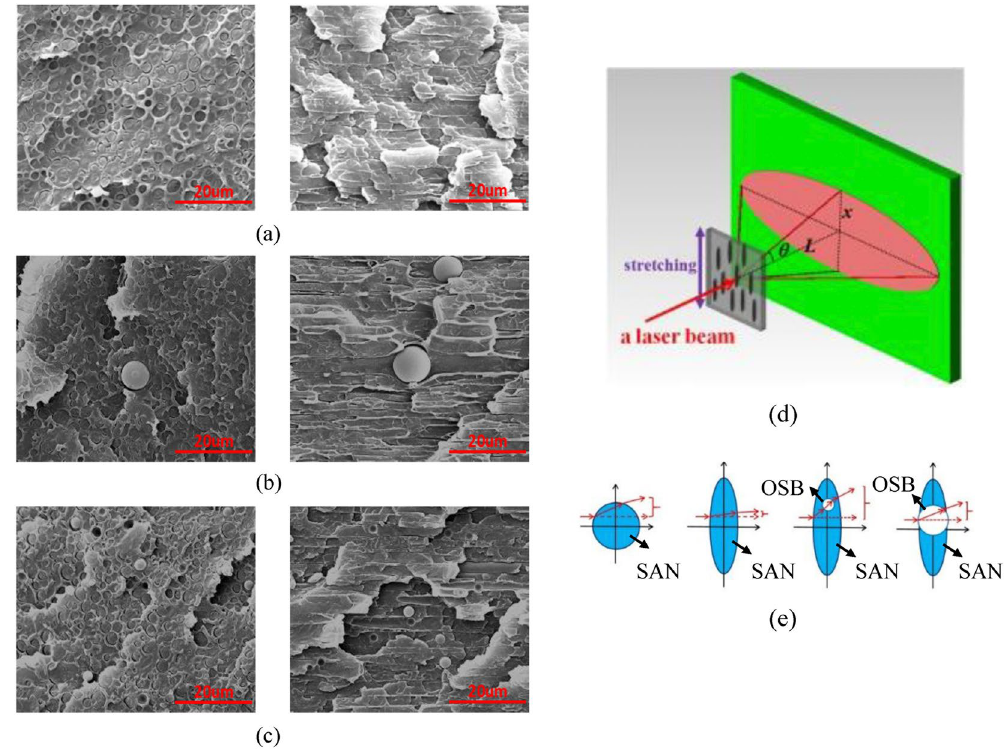
Figure 6. ( a ) The SEM morphology of PC/SAN, the draw ratio is 2. ( b ) and ( c ) The SEM morphologies of 1-2- 1.0 and 2-2-1.0, respectively. ( d ) and ( e ) Schematic diagram of light-scattering materials and light-scattering particles with the spindle-shaped core-shell